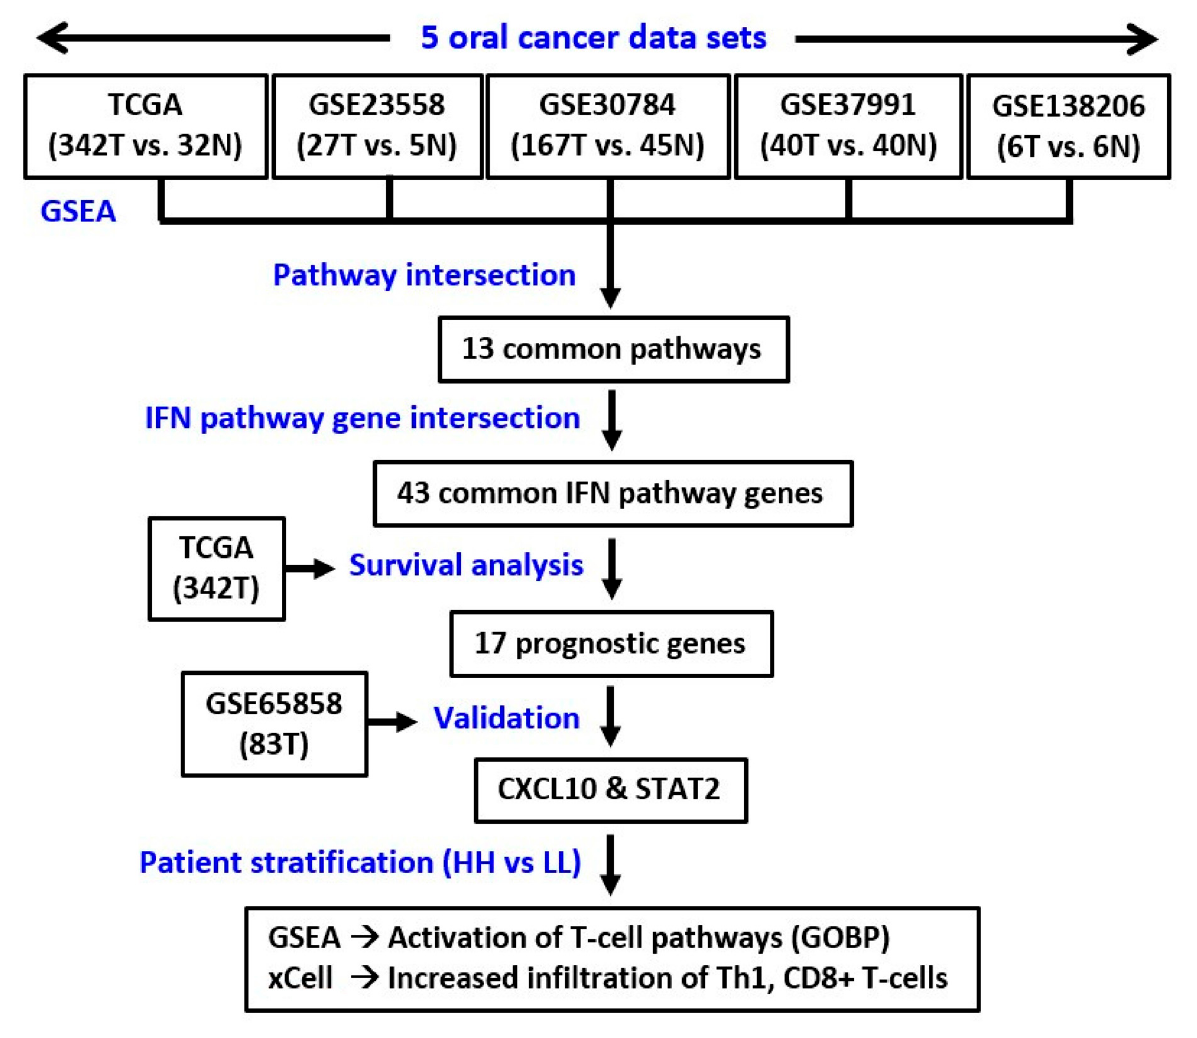
Figure 1. The study pipeline. T, tumor. N, normal. GSEA, gene set enrichment analysis. GOBP, Gene Ontology Biological